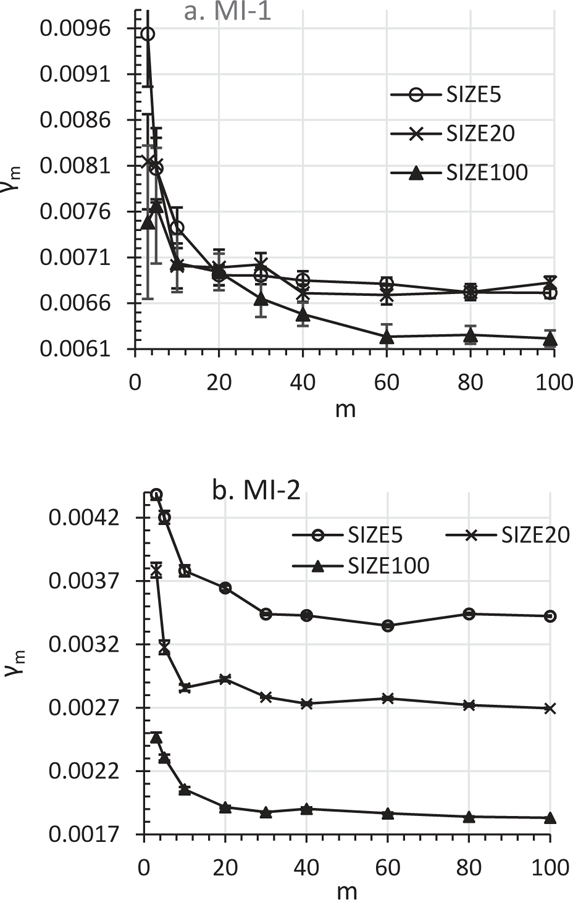
Effects of m on γm at δ = 29% for analytic model = Anal-2: MI model = MI-1; b. MI model = MI-2.